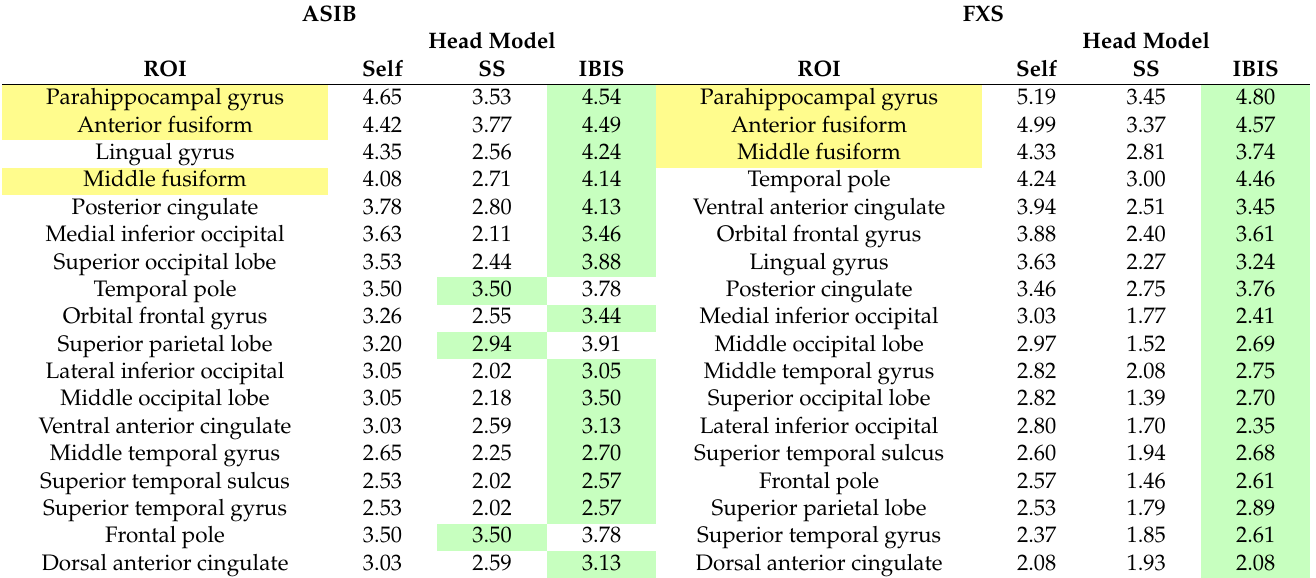
Table 3. Mean CDR amplitude separately for ASIBs and infants with FXS at each ROI as calculated using the Self, study-specific (SS), and IBIS head models. Yellow highlights indicate ROIs identified as the sources of the N290 in research with typically developing infants. Green highlights indicate the head model (i.e., study-specific or IBIS) closest in CDR activation to the Self head model at each ROI.